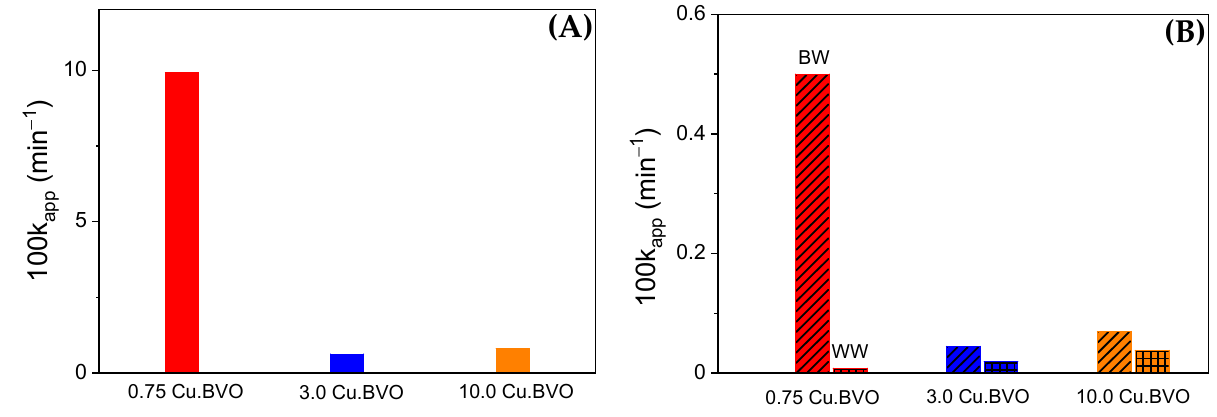
Figure 4. Apparent kinetic constants for Cu.BVO photocatalysts in ( A ) UPW, ( B ) BW, and WW. Experimental conditions: 0.5 mg/L SMX, 100 mg/L SPS, and 500 mg/L catalyst. On the contrary, as shown in Figure 4B, apparent kinetic constants for all copper loadings tested were some orders of magnitude lower in real water matrices due to the presence of co ‐ existing inorganic and organic ions competing with SMX for ROS [36] and catalyst surface. Specifically, in BW, 0.75 Cu.BVO was also the best performing photocatalytic material; however, its k app was found to equal 0.0433 min − 1 . Interestingly, its k app decreased to 0.0191 min − 1 for 3.0 Cu.BVO, whereas it was found to equal 0.0227 min − 1 for 10.0 Cu.BVO. This observation implies that the optimum loading of a co ‐ catalyst, such as metal oxides, is closely connected with the experimental parameters, such as water matrix, in agreement with other studies [37]. This behavior was further confirmed by experiments carried out in WW. As shown in Figure 4B, SMX degradation was faster when a copper ‐ promoted sample with higher copper loading, 10.0 Cu.BVO, was used. In addition, a 0.75 Cu.BVO sample that showed the best photocatalytic results in UPW and BW was now characterized by the lowest k app . In general, retarding phenomena were more intense in WW than in BW, making SMX degradation practically non ‐ viable. In order to moderate hindering phenomena in real water matrices, SPS was added to the photocatalytic system, and the degree of synergy was quantified. At first, the efficiency of the hybrid system solar/SPS/catalyst was studied in UPW; results are shown in Figure 5.